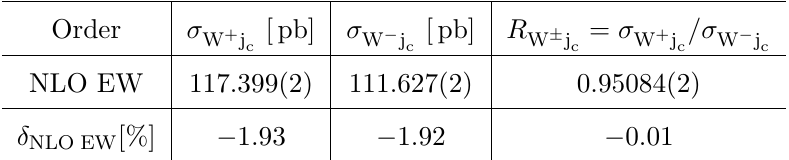
Table 2 . Fiducial cross sections and relative NLO EW corrections at order O W + j , pp → W − j , and their ratios at the LHC at c c in these predictions. The digit in parenthesis indicates the Monte Carlo statistical error. The full CKM matrix and the NNLO NNPDF3.1 set with α